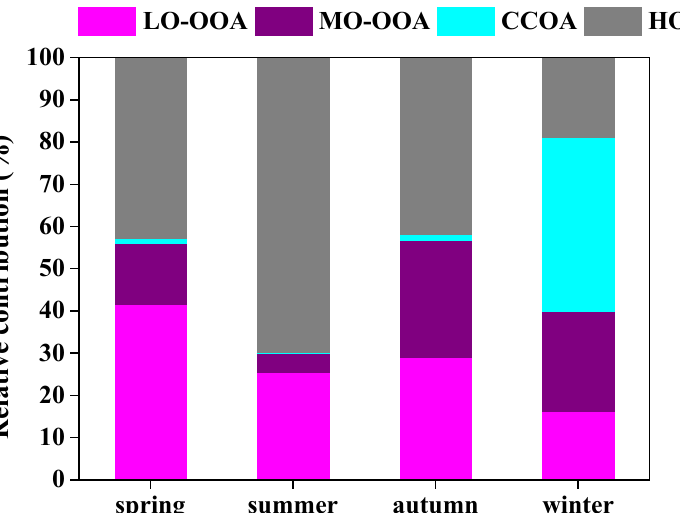
Figure 7. The relative contribution of LO-OOA, MO-OOA, CCOA, and HOA to WSOC during the sampling periods in different